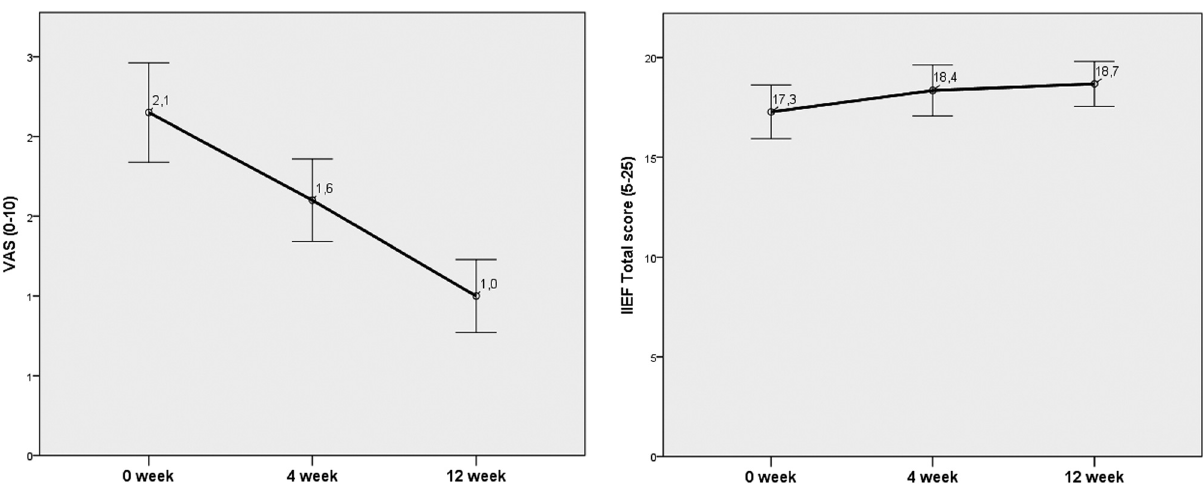
Figure 4: Changes in the VAS score for pain.